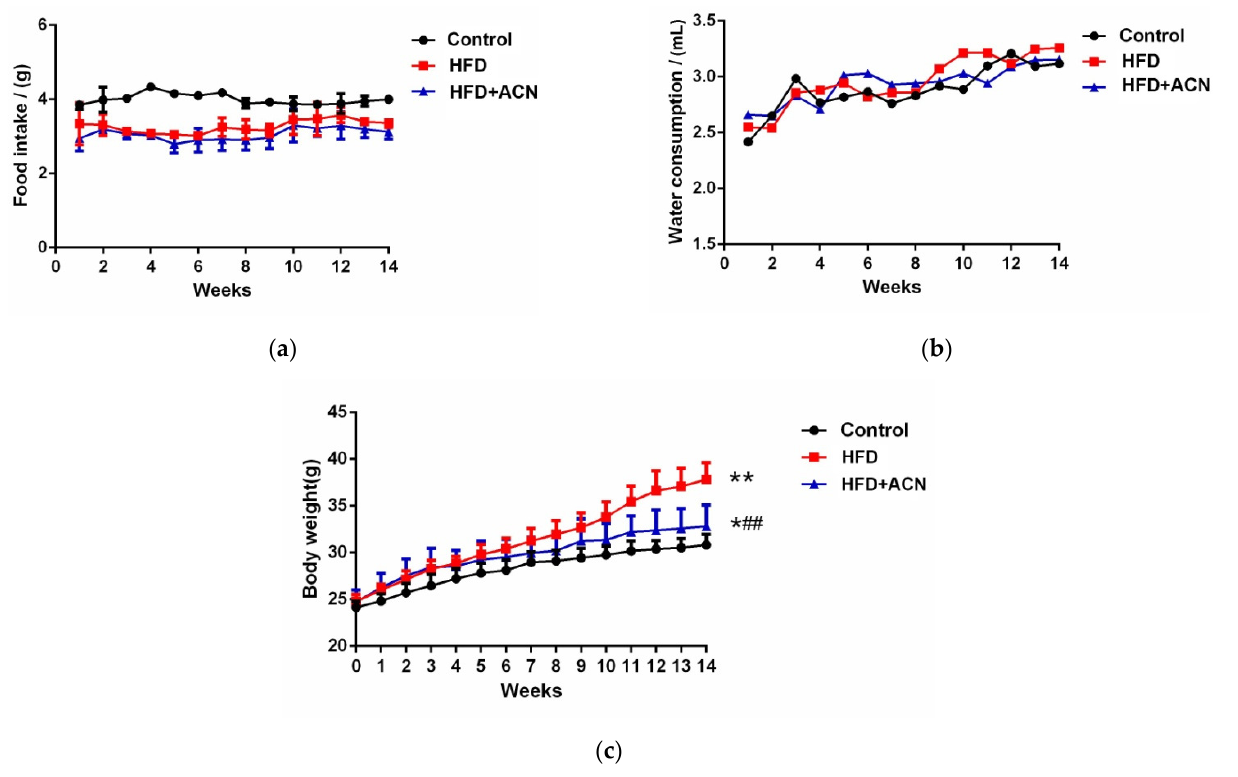
Figure 1. The effects of anthocyanin extract from the fruits of L. ruthenicum supplementation on food intake, water consumption, and body weight in high-fat-fed C57BL/6 mice. Data are expressed as the mean ± SD (n = 8 for each group), Compared with the control group, * denotes p < 0.05; ** denotes p < 0.01. Compared with the high-fat diet, ## denotes p < 0.01. ( a ) Food intake. ( b ) Water consumption. ( c ) Body weight.